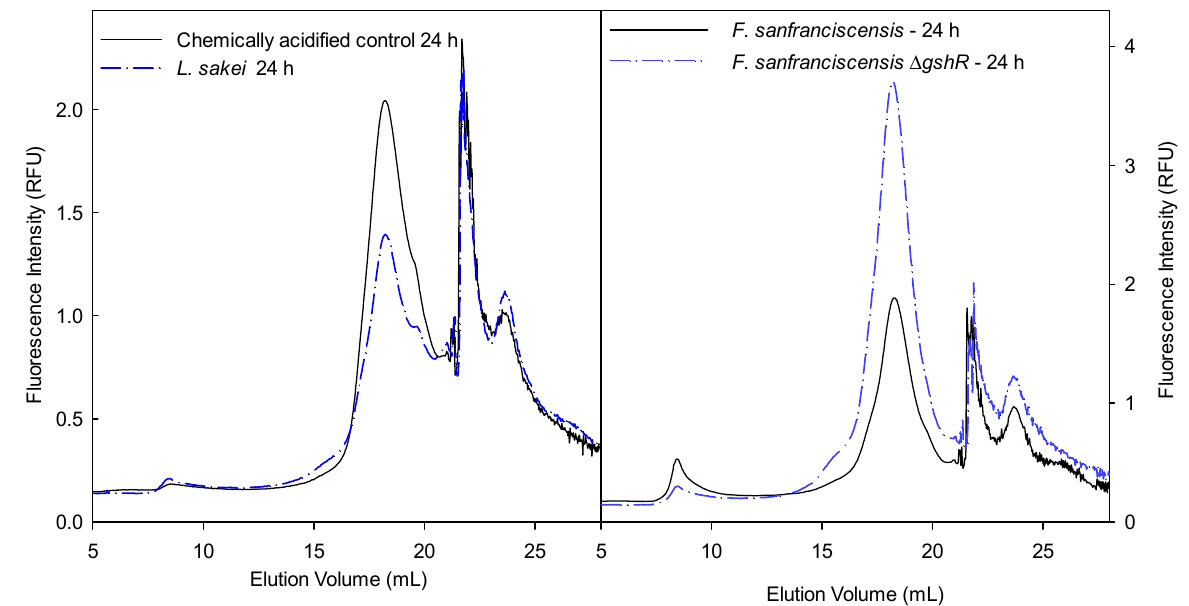
Figure 2. Chromatogram of fluorescence labeled WGA. WGA was extracted from chemically acidified doughs after 24 h of incubation and compared to Latilactobacillus sakei sourdough after 24 h of fermentation (left panel) and extracted from doughs fermented with F. sanfranciscensis DSM20451 ∆ gshR and compared to F. sanfranciscensis DSM20451 after 24 h of fermentation (right panel).